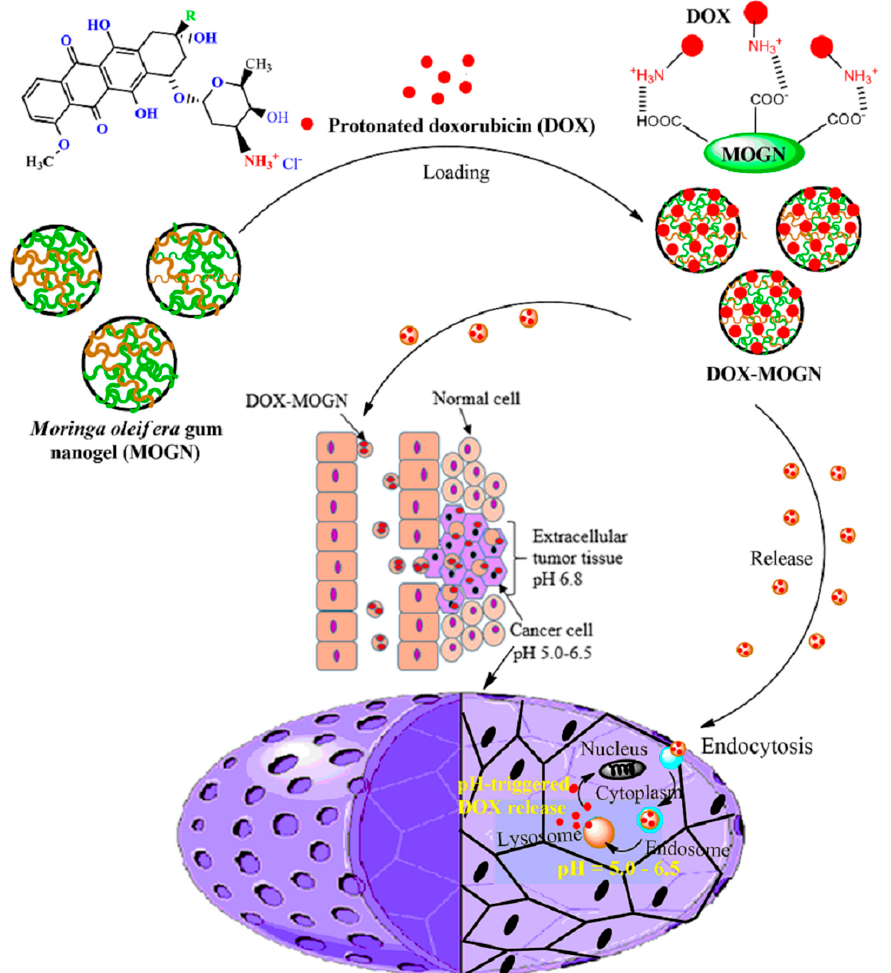
Scheme 3. Schematic presentation of the DOX loading and pH–triggered intracellular DOX release from DOX-MOGN in a tumor cell.